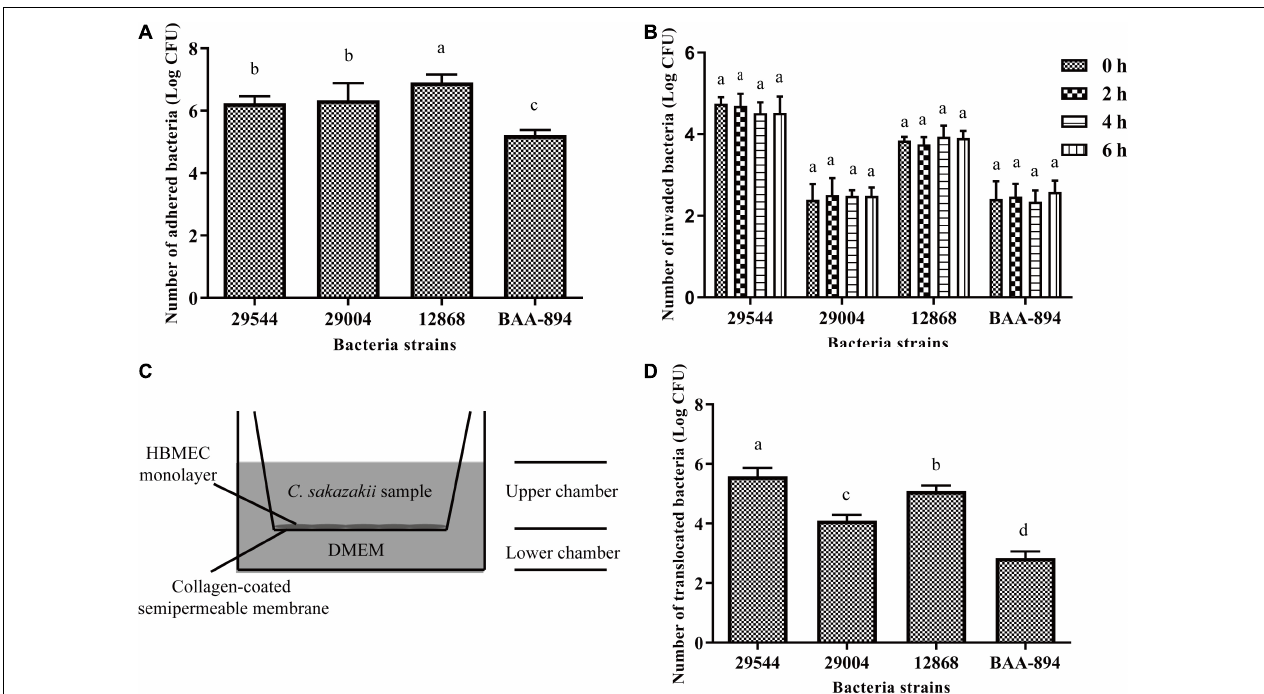
FIGURE 1 | Adhesion, invasion, intracellular replication, and translocation of C. sakazakii in HBMEC. (A) The number of C. sakazakii cells that adhere to HBMEC. (B) The number of C. sakazakii cells in HBMEC after 2 h invasion and intracellular bacteria counts at 2, 4, and 6 h post-invasion. (C) HBMEC were incubated in transwell inserts. (D) The counts of C. sakazakii that translocated HBMEC monolayers were calculated. The strain ATCC 29544 performed the strongest invasion and translocation abilities compared to other strains ( P < 0.01). Bars represent the means ± standard deviations ( n = 3). Mean values with different lower-case letters are statistically different ( P <